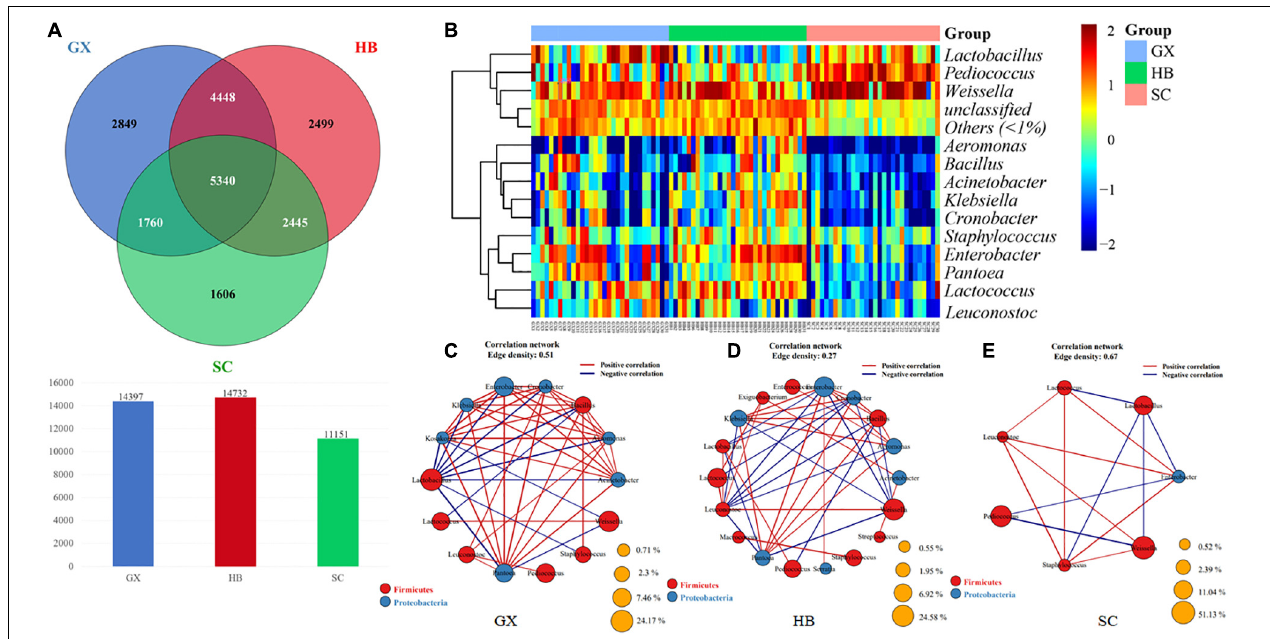
FIGURE 4 | (A) Venn diagram showing the number of taxa shared and unique between HB, GX, and SC samples at the genus level. (B) Analysis of similarity among rice wine koji samples fermented in different regions based on the relative abundance of fungal OTUs (operational taxonomic units). (C–E) Correlation analysis of dominant